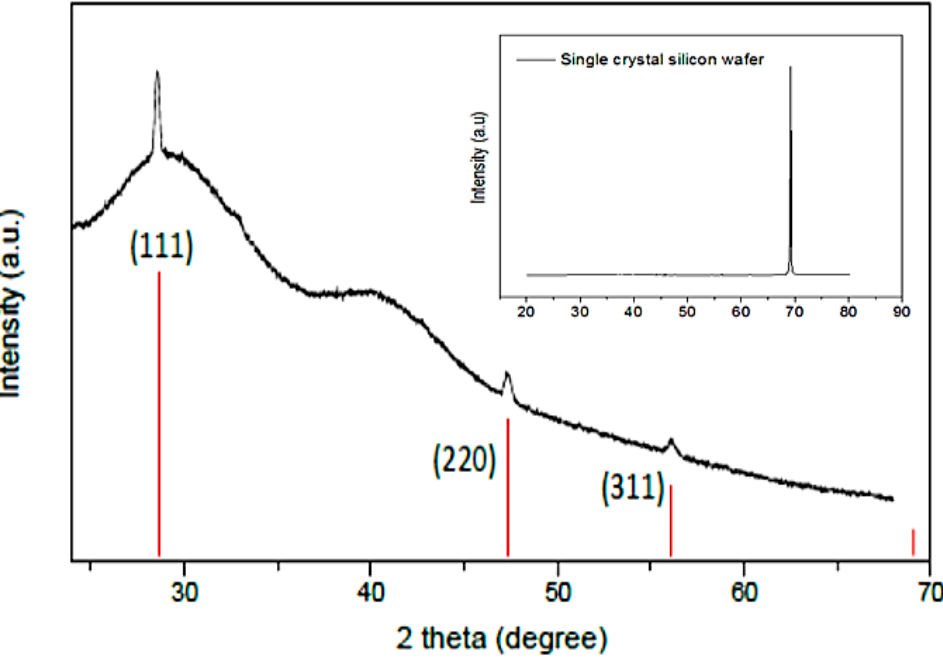
Figure 4. XRD pattern of the as-etched silicon nanoflakes. Inset: XRD pattern of the n-type silicon wafer with orientation (001).